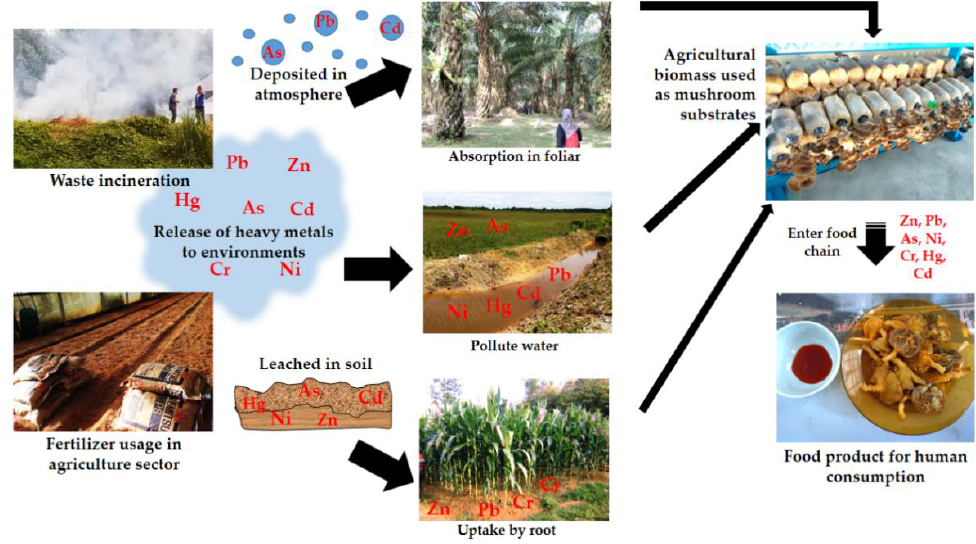
Figure 1. Bioaccumulation of heavy metals in mushrooms enters the food